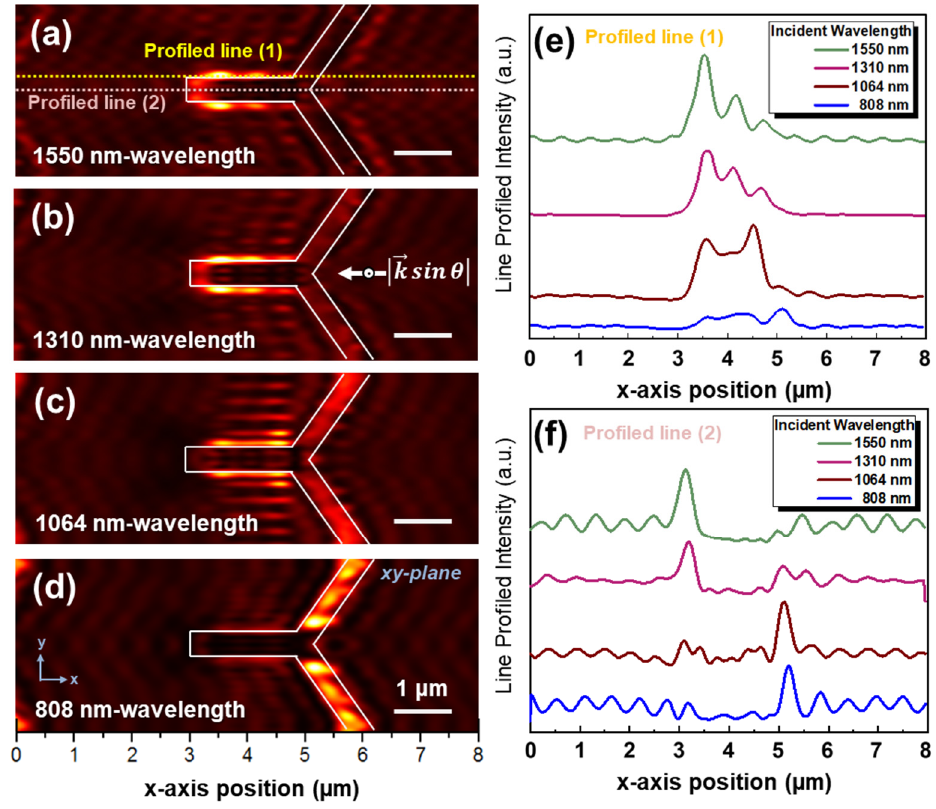
Figure 4. Simulation results of plasmonic near-field electromagnetic fields distributions for T-shaped nanostructure arrays by incident light with wavelengths of ( a ) 1550, ( b ) 1310, ( c ) 1064, and ( d ) 808 nm. ( e ) Intensities of localized electromagnetic fields at ( e ) the edge (profiled line (1)) and ( f ) the center (profile line (2)). The information of incident light source is indicated in ( b ).